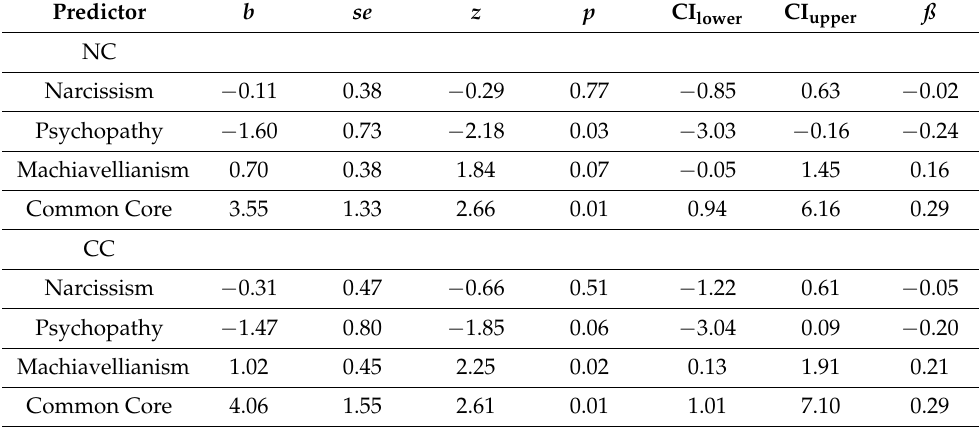
Table 9. Regression weight